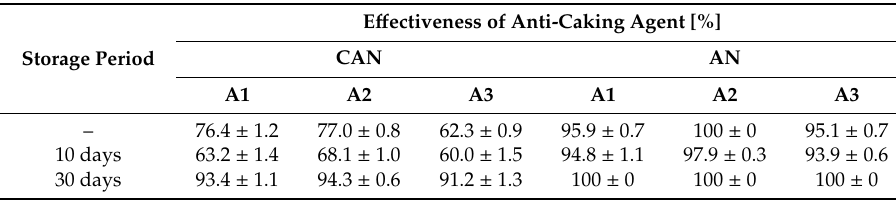
Table 5. E ff ectiveness of anti-caking